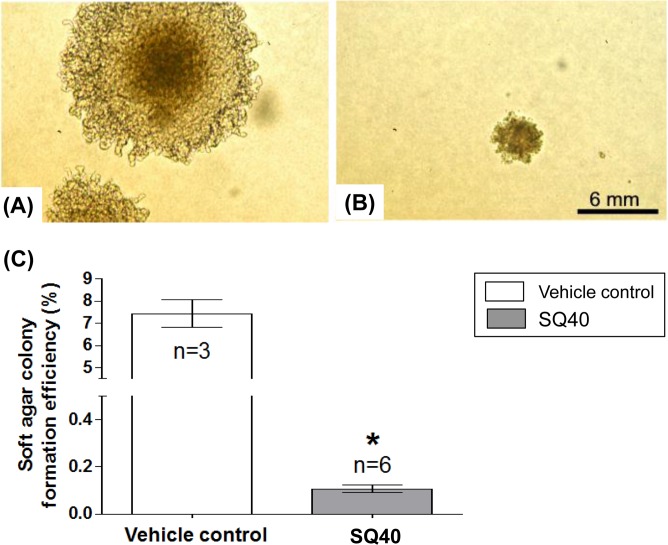
The effects of SQ40 on LNCaP cells anchorage-independent growth.LNCaP cells were pre-treated with SQ40 or vehicle control for 72 hours and then plated on the soft agar media for another 3 weeks. Representative colonies of (A) vehicle control and (B) SQ40-treated LNCaP cells are shown. (C) Graphical representations of soft agar colony formation efficiency. Data were expressed as mean ± SEM of three independent experiments for vehicle control cells and six independent experiments for SQ40-treated cells. * indicates p<0.05 versus vehicle control.